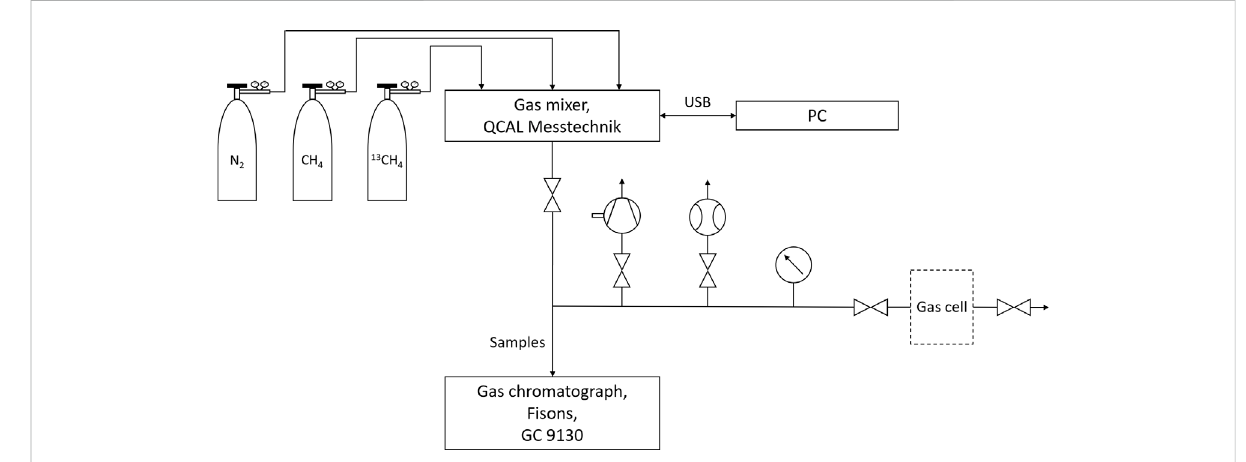
FIGURE 4 Gas fl ow system.